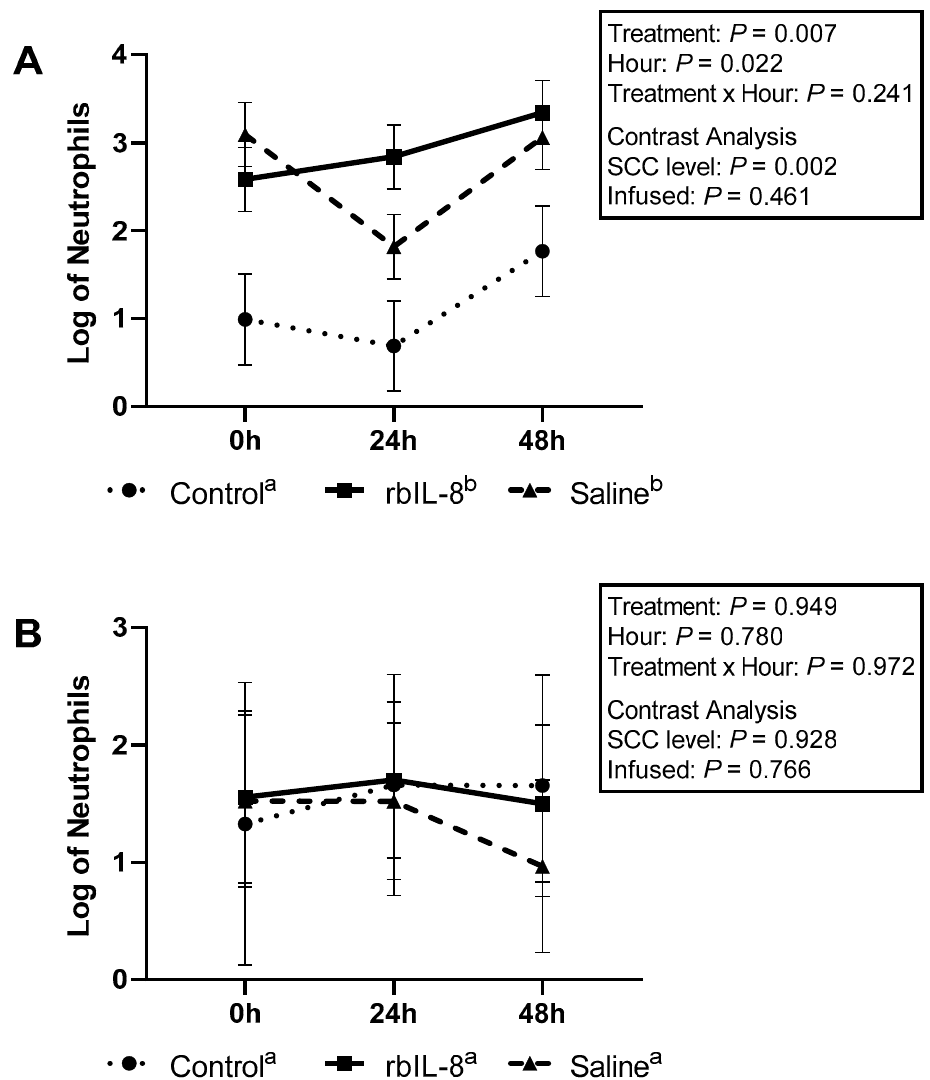
Figure 5. Log of neutrophils isolated from milk ( A ) and from blood samples ( B ) that presented a high fluorescence for both propidium iodide (PI) and dihydrorhodamine 123 (DHR) relative to hours post-treatment based on flow cytometry. The treatment effect is a multiple comparison analysis among the groups. The SCC level was measured using a contrast comparing the chronic groups (rbIL-8 and saline) to the control, whereas the infused was compared to the rbIL-8 with the saline. Multiple comparisons were adjusted for Tukey–Kramer. Groups with different superscripts a,b differed for the mean ± SE of log of neutrophils, in the multiple comparison analysis; p = ≤ 0.05 means a statistical significance, and 0.05 < p ≤ 0.10 means a statistical tendency.